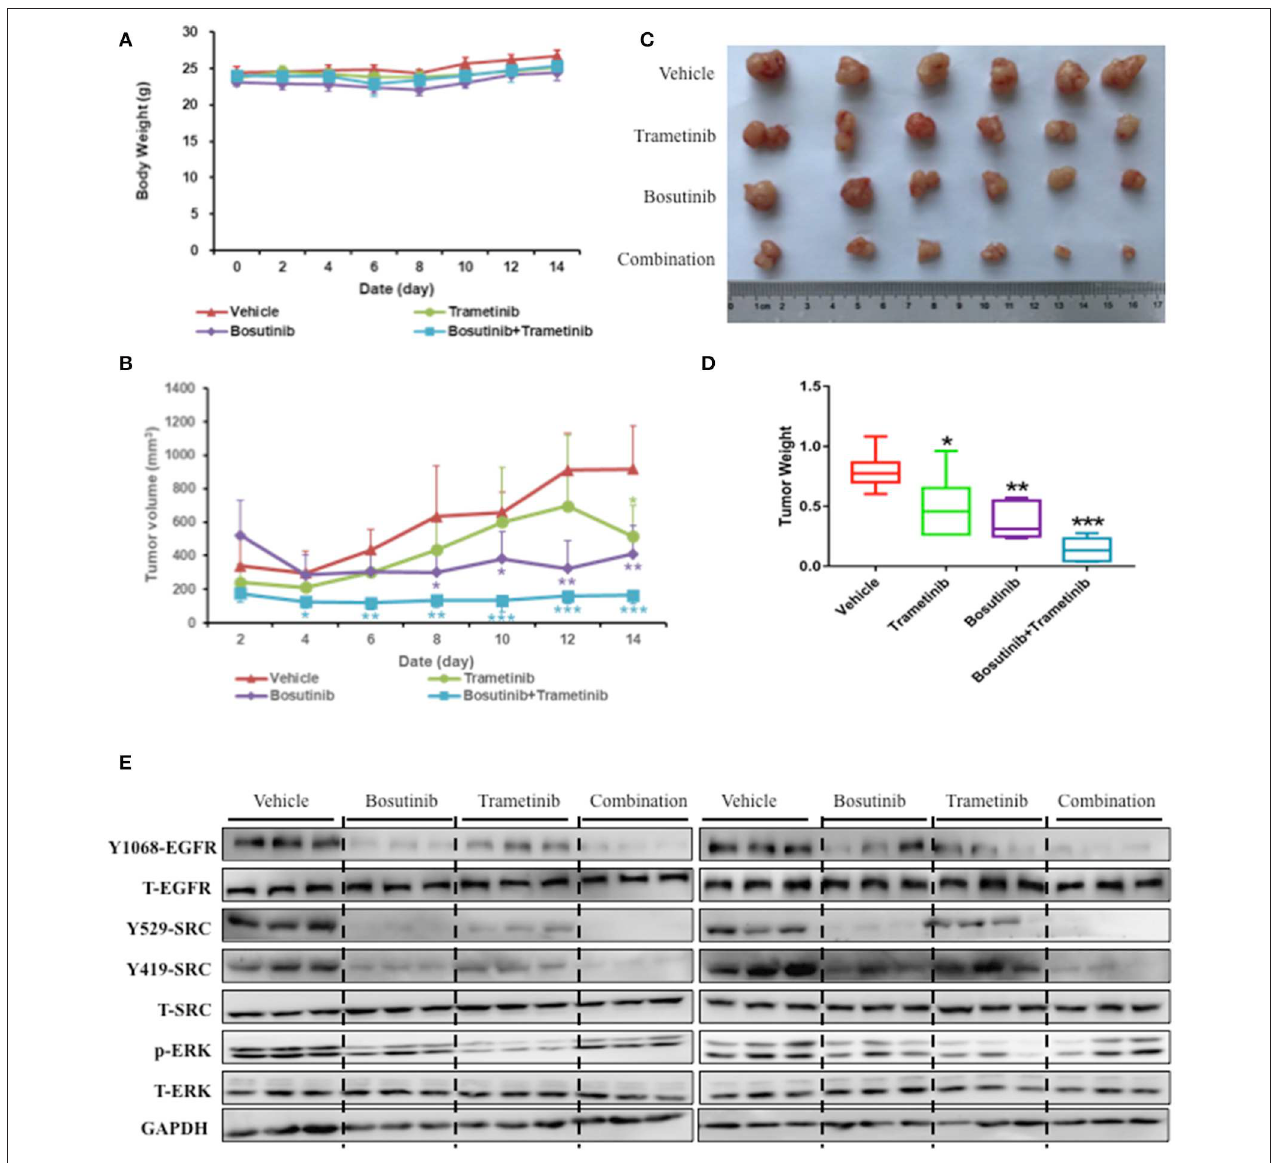
FIGURE 5 | The combination of trametinib and bosutinib showed synergistic effects against xenografted tumors in nude mouse. HCC827 cells (1 × 10 6 cells per mouse) were implanted subcutaneously into the dorsal flank of nude mice. When the tumors reached approximately 75 mm 3 , the tumor-bearing mice were then treated with vehicle, trametinib (e.g., 0.4 mg/kg), bosutinib (e.g., 60 mg/kg), or their combination once daily for 14 days. After treatment, the mice were killed. (A) Body weights and (B) tumor volumes of the animals were measured every 2 days. Tumors were removed, photographed (C) , and weighed (D) . (E) Western blotting analysis of the expression levels related to EGFR signaling pathway in mouse tumor sections. Data are expressed as means ± SD. * P < 0.05, ** P < 0.01, *** P < 0.001 compared to the control ( n =